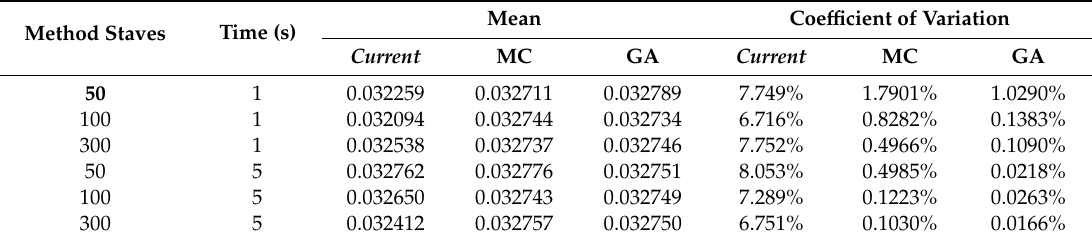
Table 3. Results of the construction of 50 bodies with a target OTR of 0.03275 hPa / h. The parameter staves method refers to the number of staves that are considered in the method dataset (Figure 6), and the time refers to the number of seconds that the methods iterate prior to outputting the best solution that has been found during this